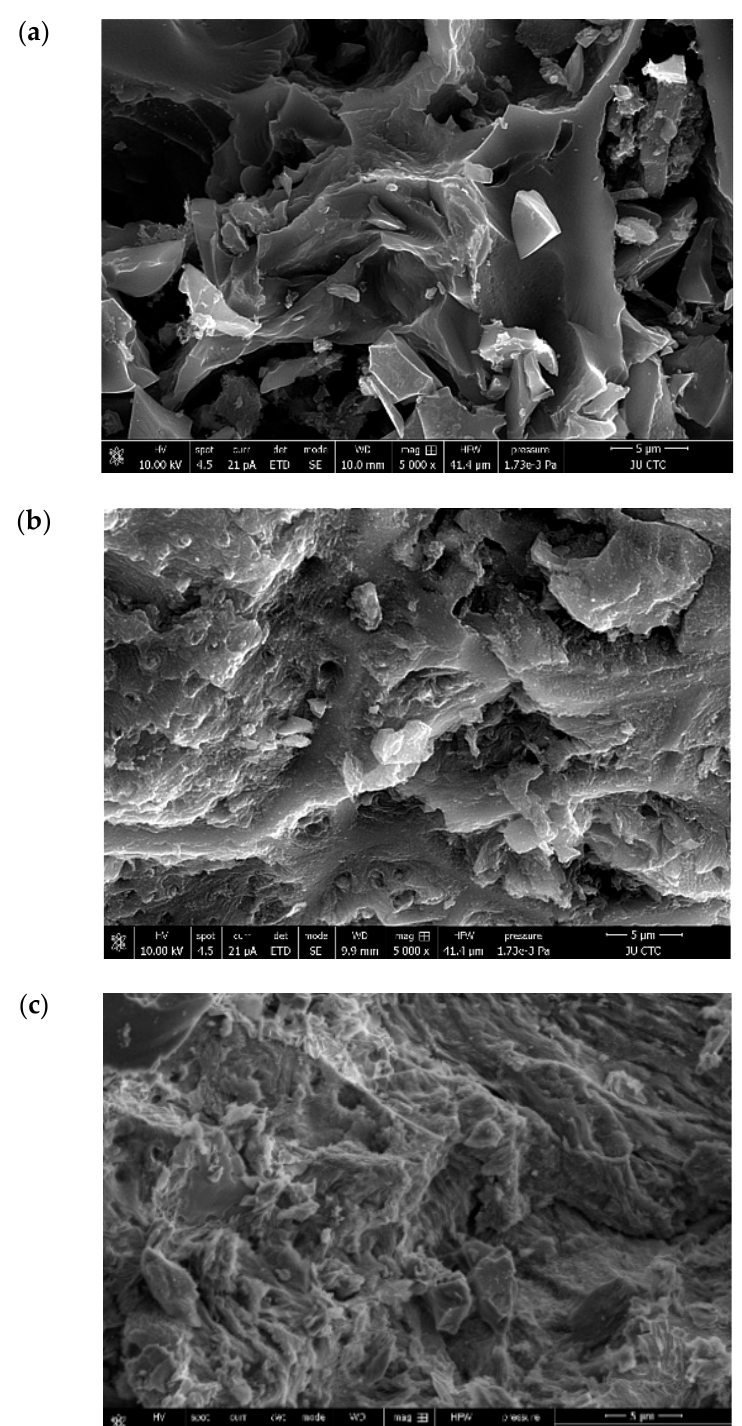
Figure 3. SEM images of ACOC ( a ) before adsorption ( b ) after adsorption of NBB and ( c ) after adsorption of CV.